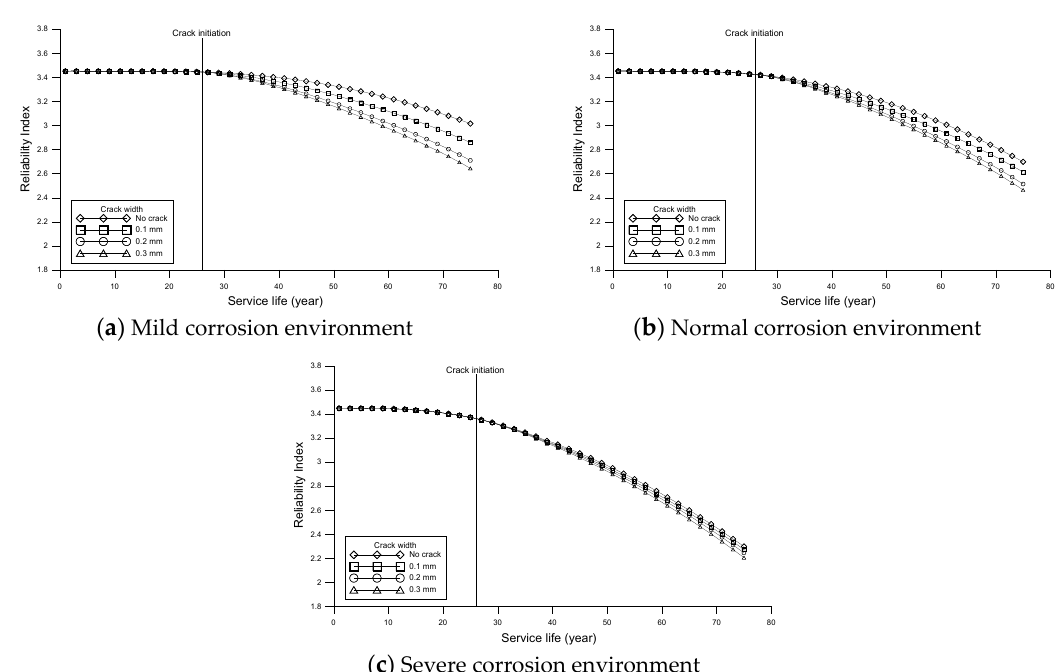
Figure 18. Reliability degradation considering crack width under normal traffic characteristics (calibrated model (2-W)).